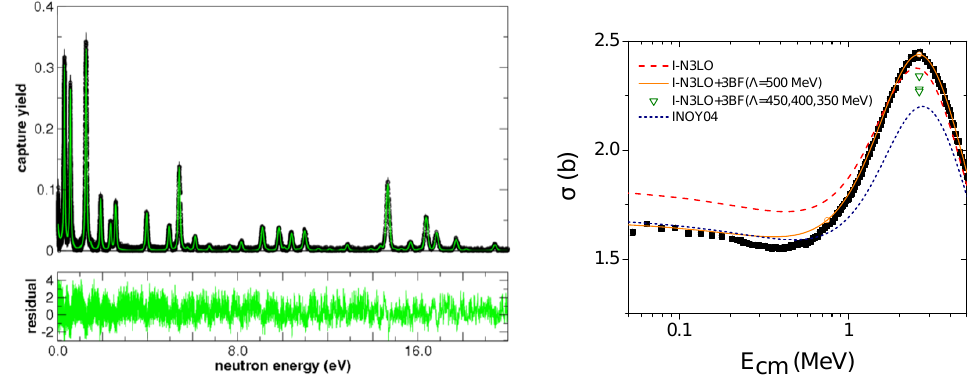
Figure 1: Left panel: low energy cross section of n on 241 Am displaying a dense ensemble of S-waves resonances at the eV energy range (from [ 1, 2 ] ). Right panel: n- 3 H low energy cross section displaying a resonant behaviour at E